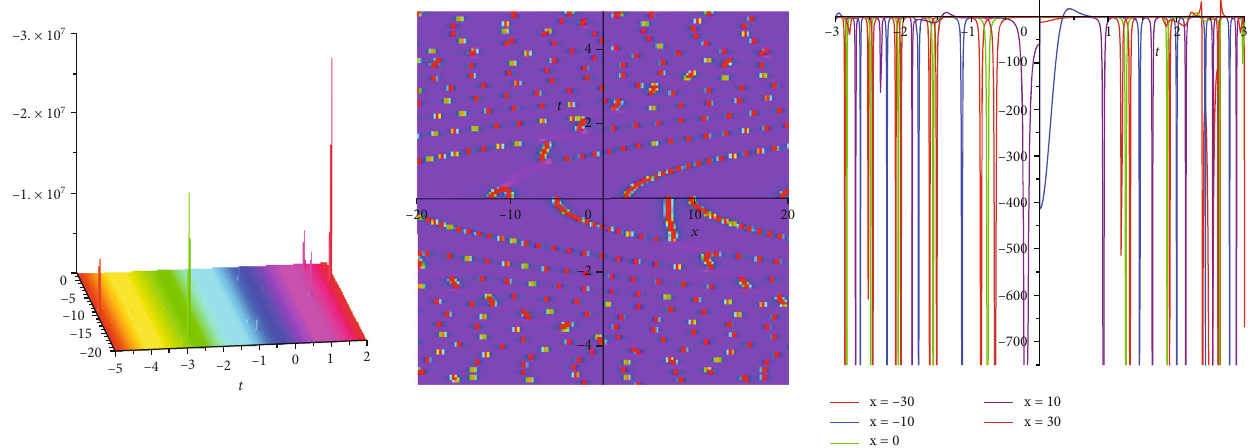
Þ (3D plot, density plot, and 2D plot t ), respectively. 1